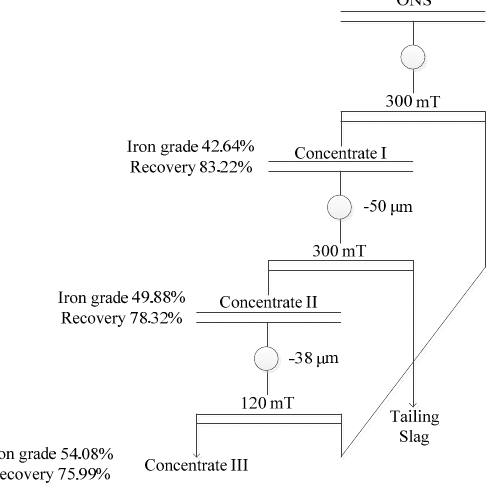
Figure 13. Flowsheet of magnetic separation for ONS. Table 2. Iron grade, yield and recovery of concentrates (wt %).